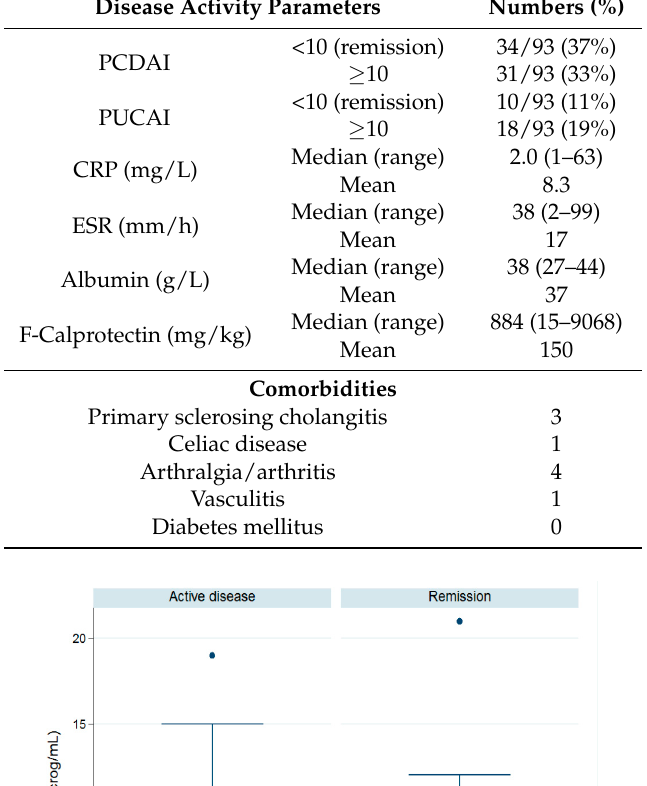
Table 2. Disease activity parameters at time of sampling. PCDAI, Pediatric Crohn’s disease Activity Index; PUCAI, Pediatric Ulcerative Colitis Activity Index; CRP, C-reactive protein; ESR, erythrocyte sedimentation rate.